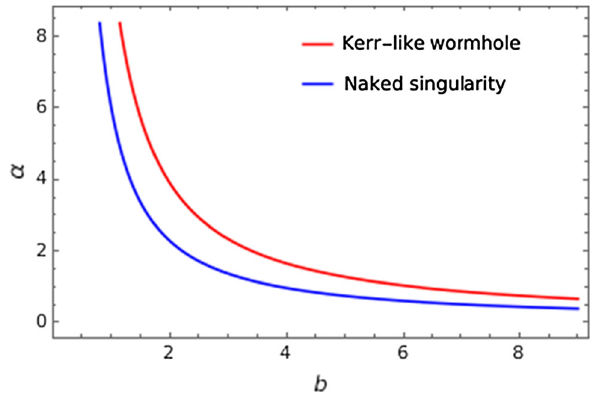
Fig. 3 The deflection angle as a function of b . We chose λ = 0 . 1, w = 0 . 8, γ = 0 . 6, m = M = a = 1